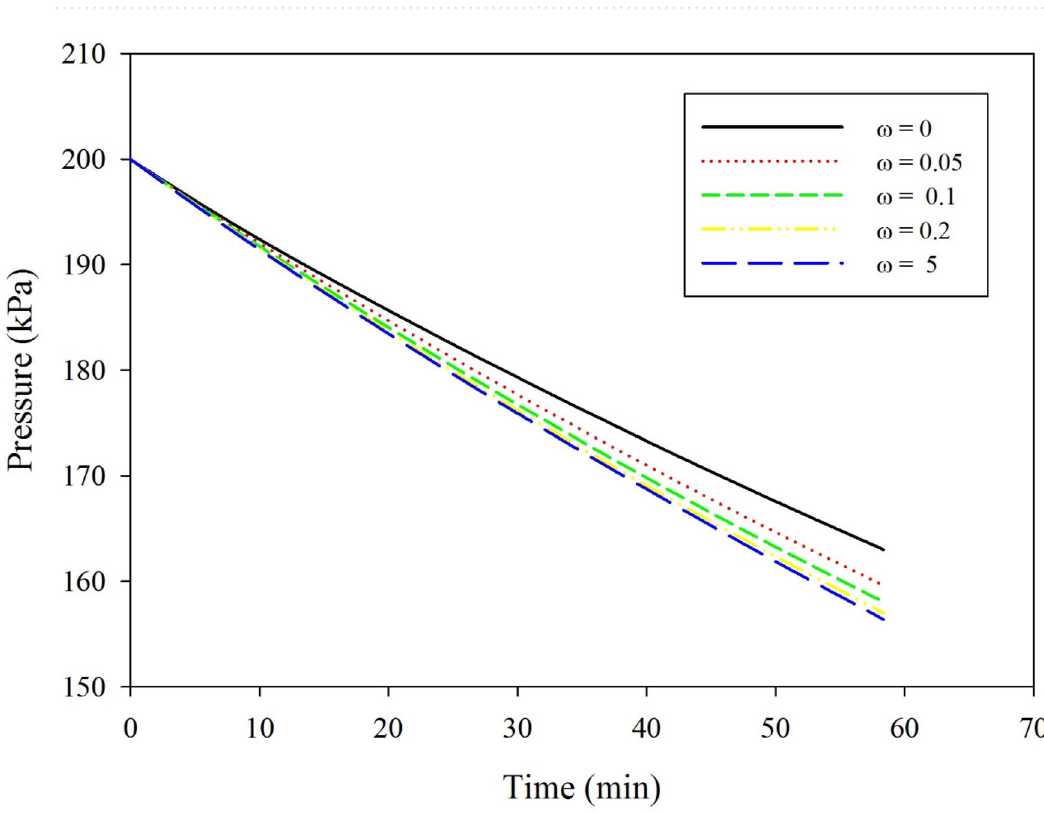
Figure 5. CO 2 pressure versus time in a stirred cell at various mixing rates; initial pressure 200 kPa; and temperature 25